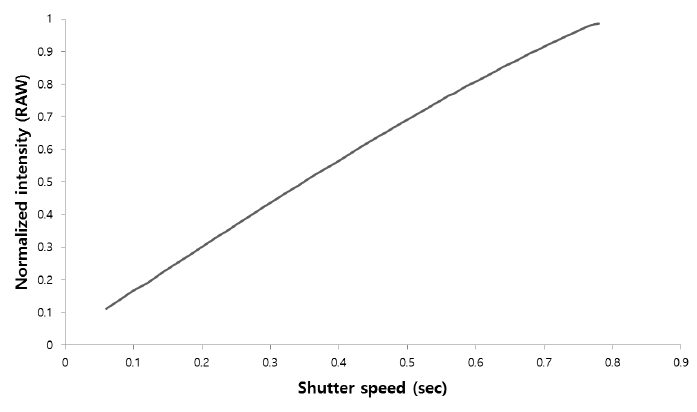
Figure 7. Camera response function of RAW image in W